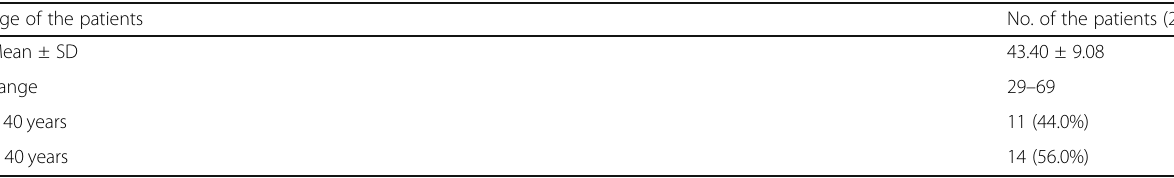
Table 1 Age of the patients